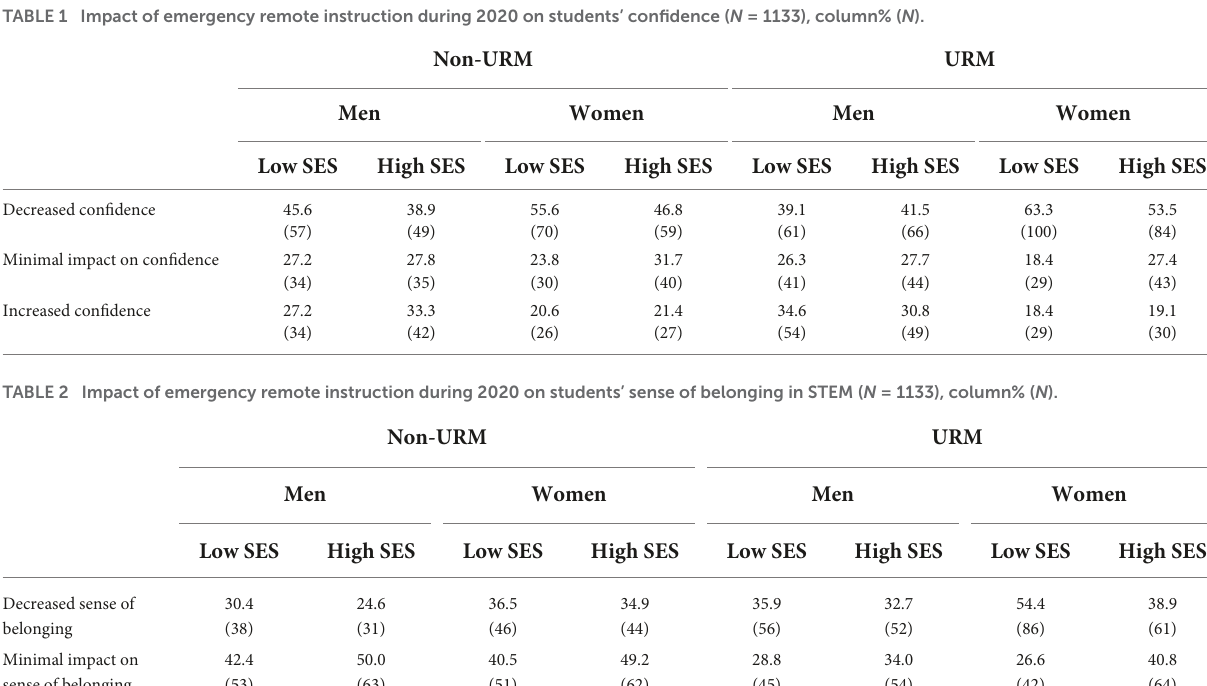
TABLE 1 Impact of emergency remote instruction during 2020 on students’ confidence ( N = 1133), column% ( N ).